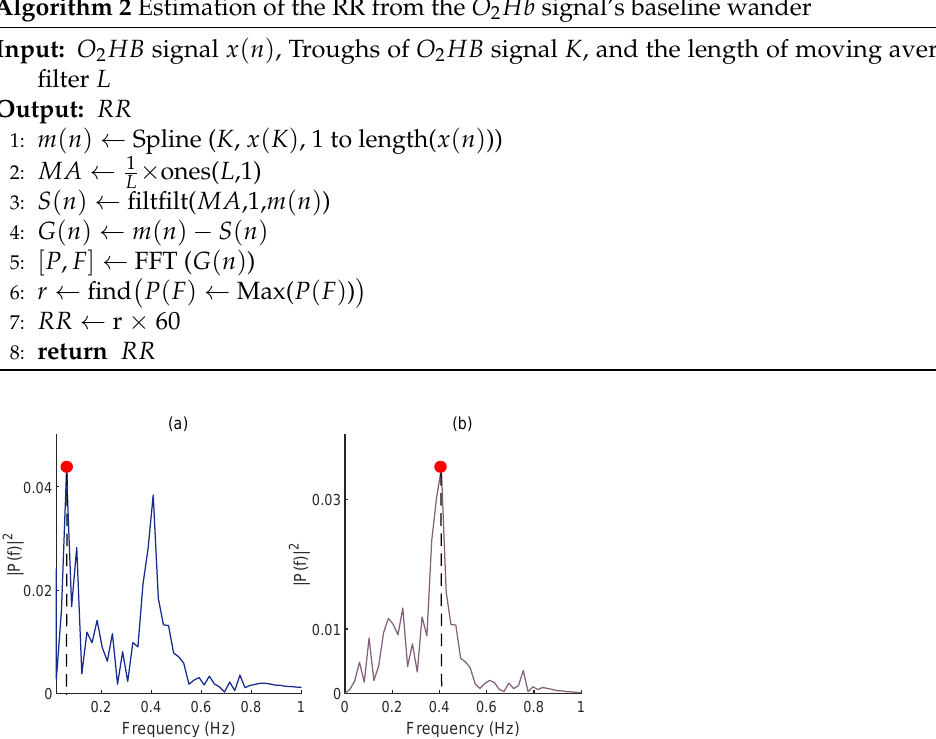
Figure 4. The FFT of the baseline wander before ( a ) and after ( b ) employing the MA filtering. The red dot stands for dominant frequency in the FFT domain. Note that the reference RR is 0.4 Hz in this